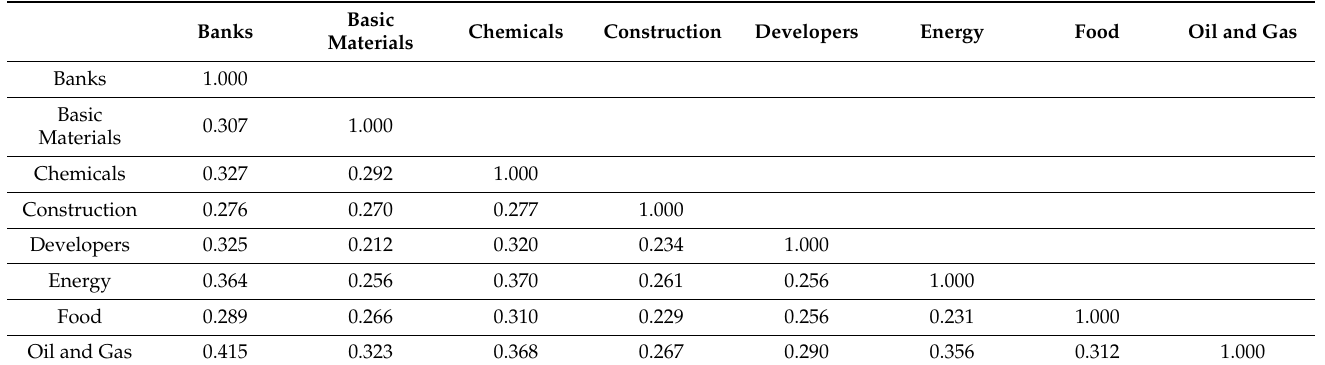
Table 4. Estimation of the Spearman correlation coefficient between the volatilities of the stock